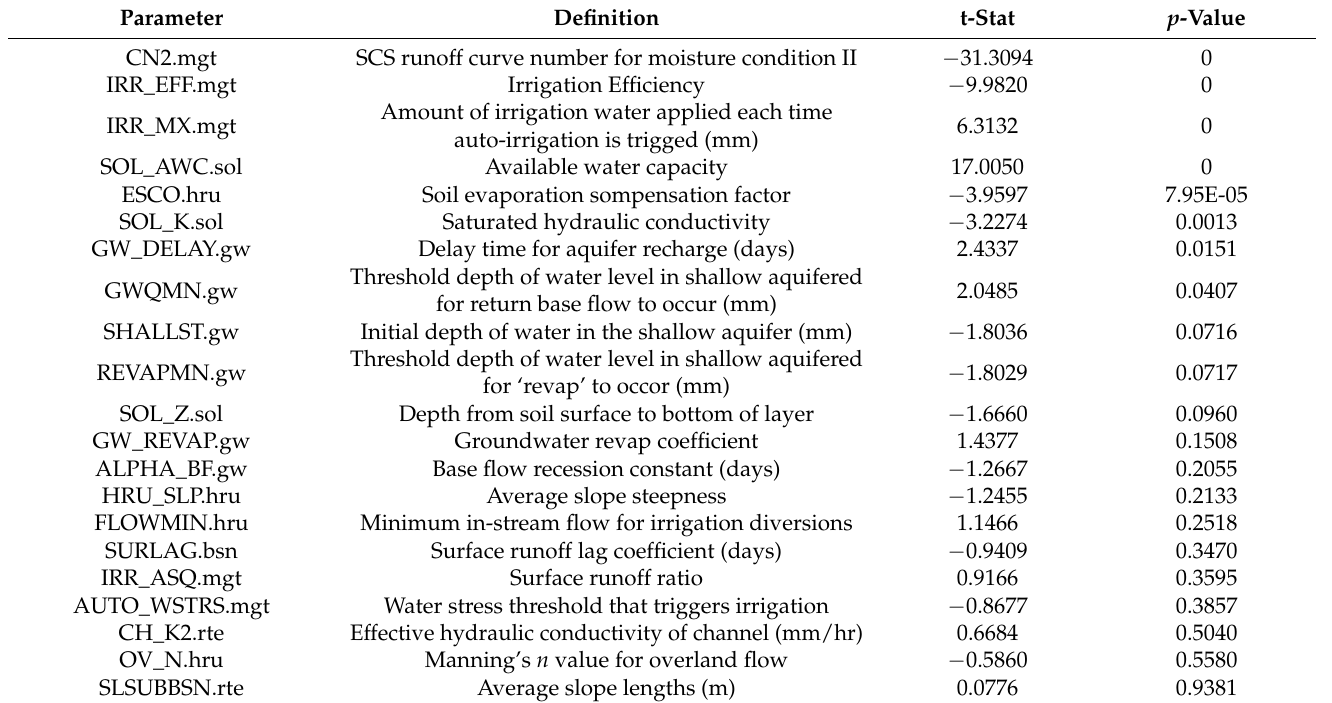
Table 4. Global sensitivity